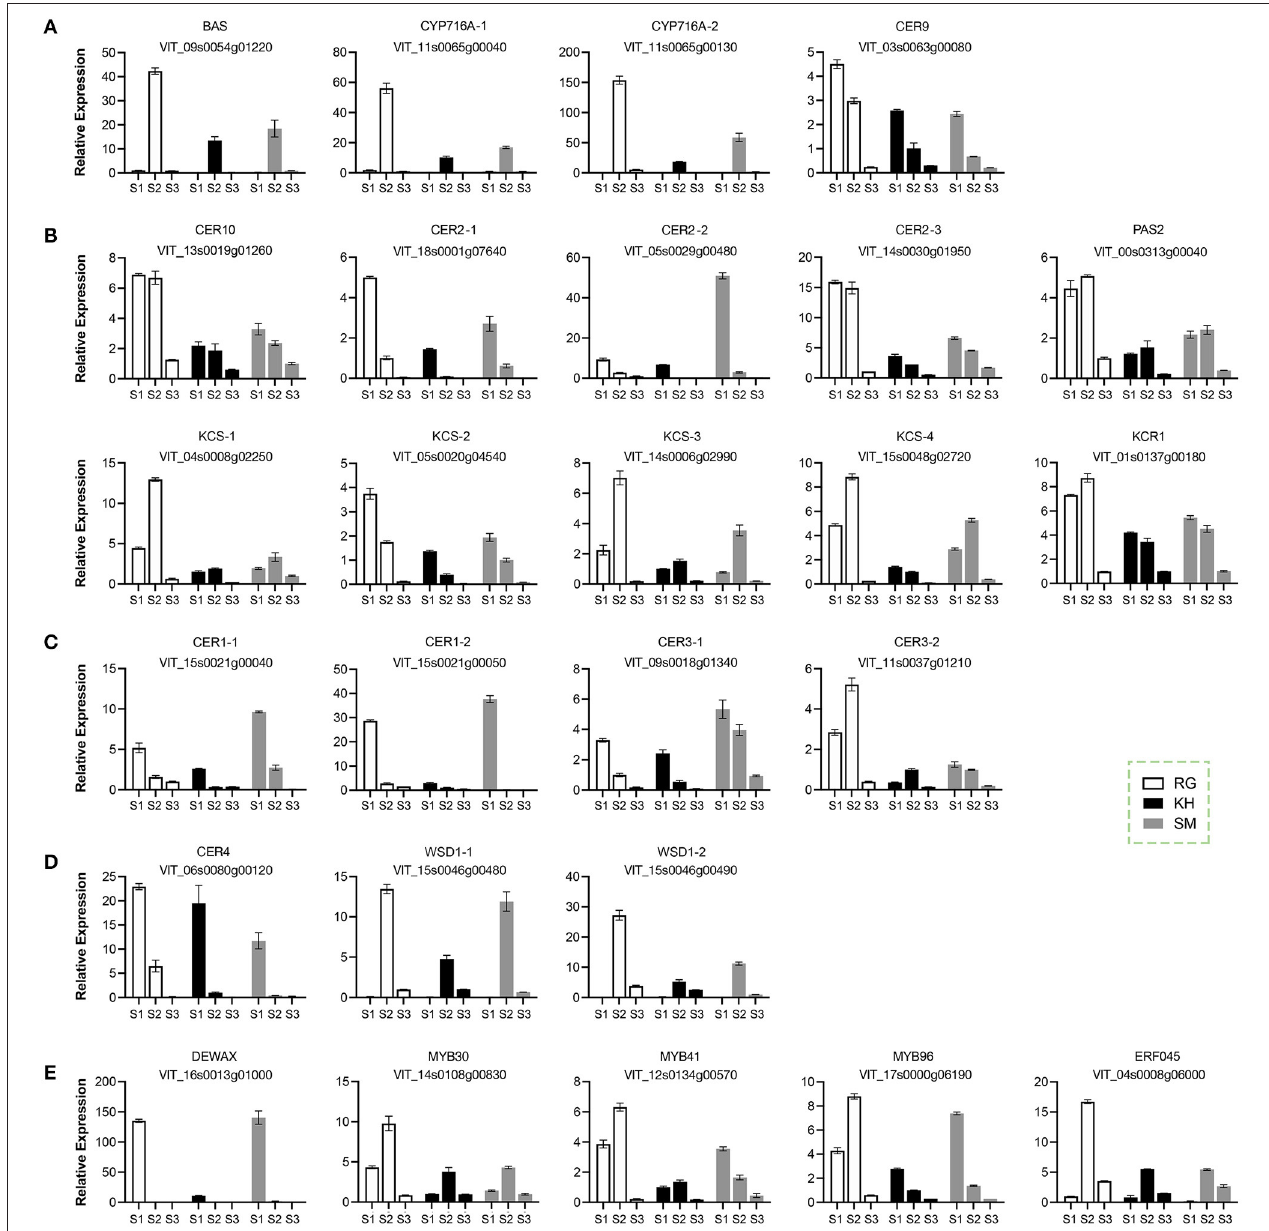
FIGURE 5 | Relative expression of wax-related gene in grape berries during development. (A) Genes involving in the triterpenoid biosynthesis. (B) Genes involving in the fatty acid elongation. (C) Genes involving in the alkane biosynthesis. (D) Genes involving in the alcohol biosynthesis. (E) Transcription factors involving in the regulation of wax. Three grape cultivars: KH, “Kyoho”; RG, “Red Globe”; SM, “Shine Muscat”. Three developmental stages: S1, mature-green; S2, véraison; S3, maturation. Error bars indicate SD from three biological